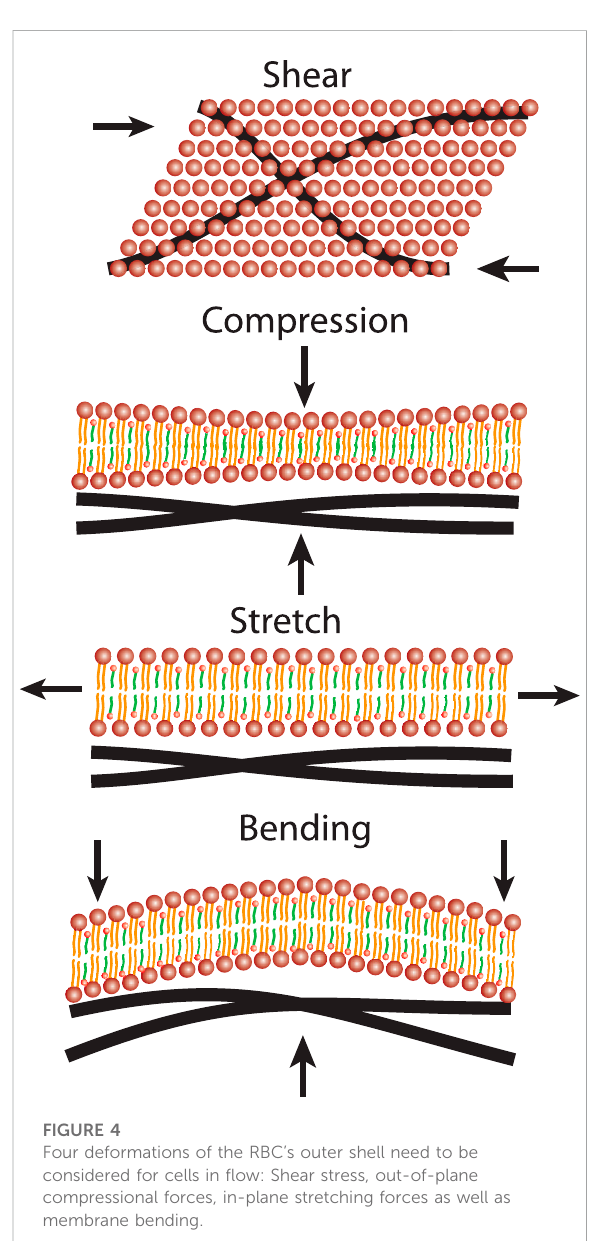
FIGURE 4 Four deformations of the RBC ’ s outer shell need to be considered for cells in fl ow: Shear stress, out-of-plane compressional forces, in-plane stretching forces as well as membrane